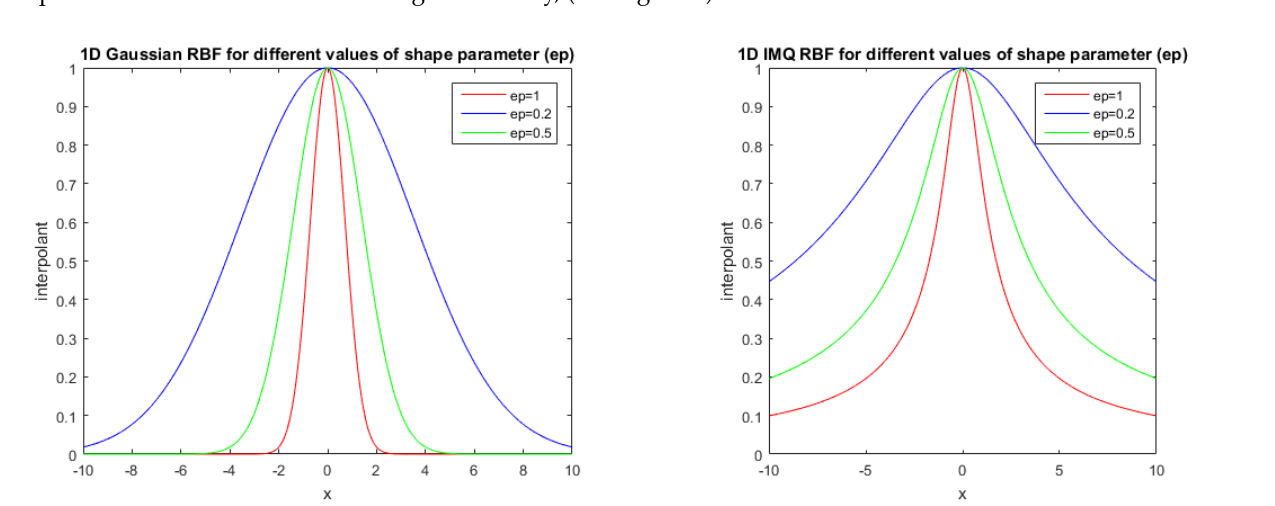
Figure 1. Shapes of 1D Gaussian and IMQ RBF of different shape